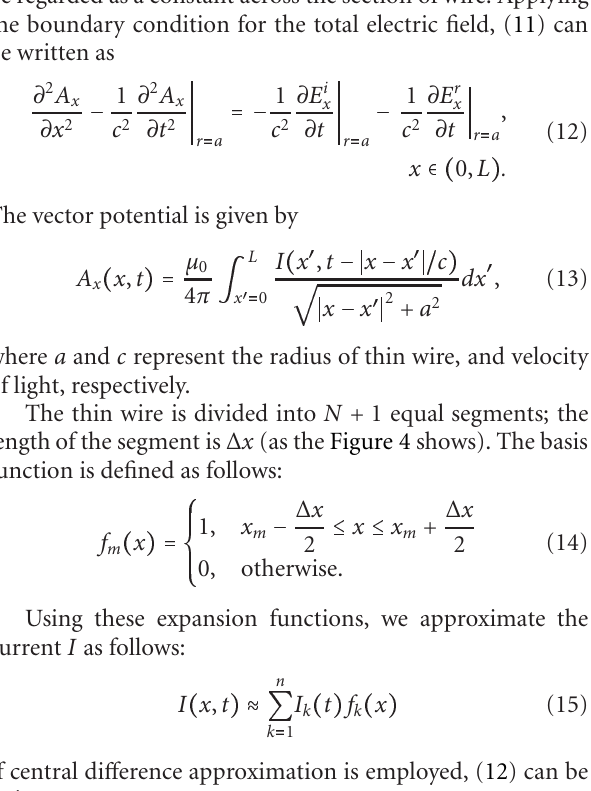
Figure 5: Current induced at midpoint of a straight thin wire above half-space.